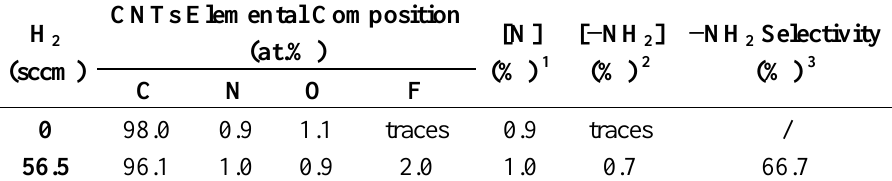
flow introduced in the μ-wave plasma 2 ] and primary amine 2